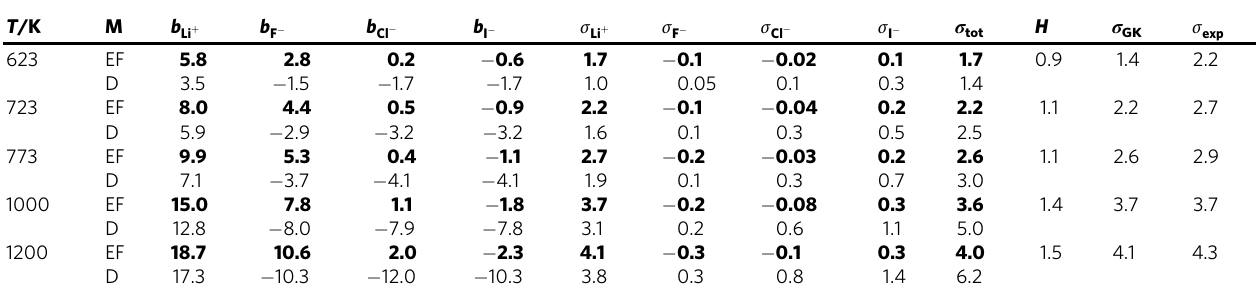
Table 2 Temperature-dependent electrical mobility and conductivity data for LiF-LiCl-LiI eut . T /K